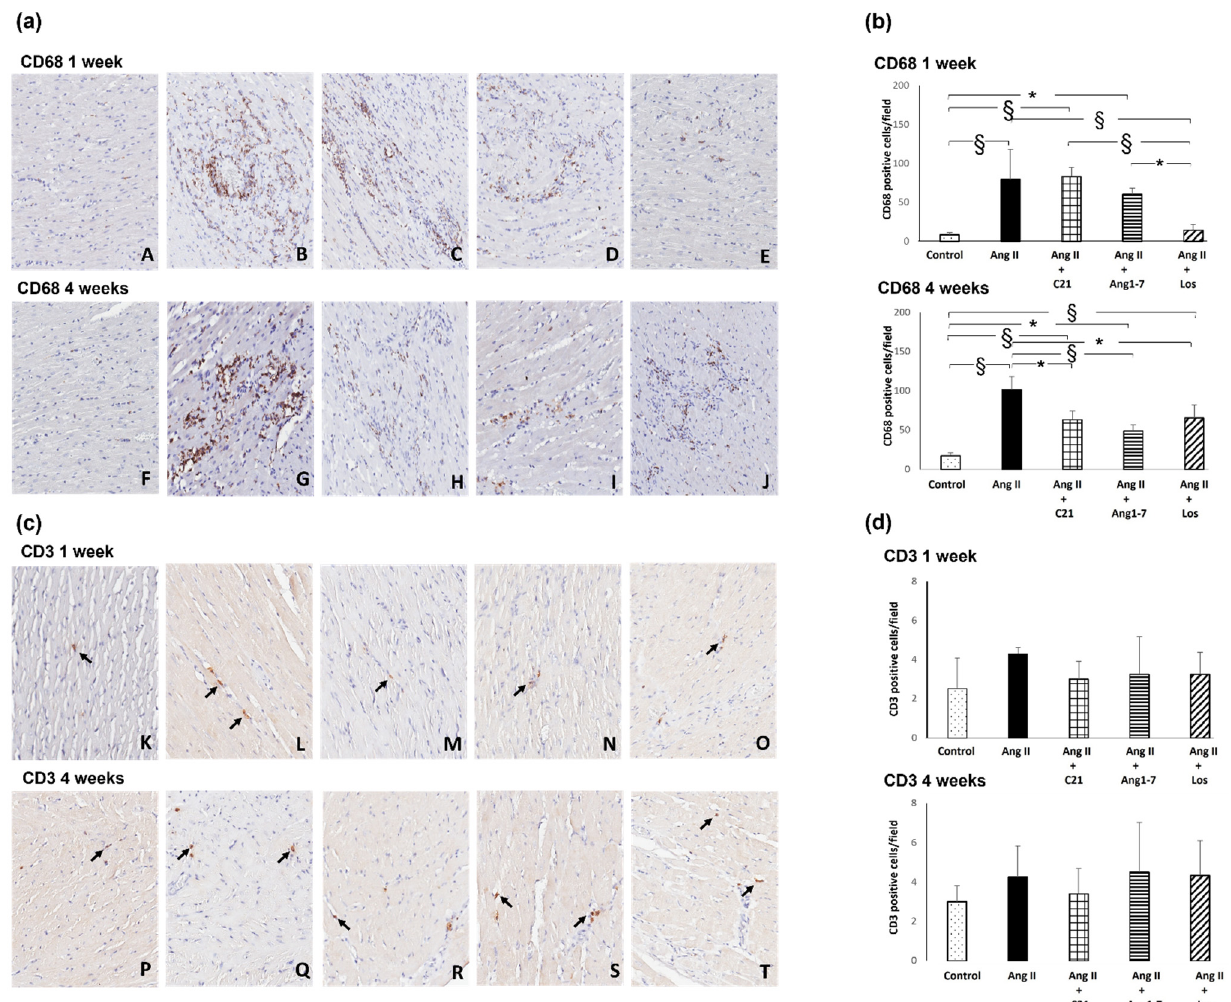
Figure 4. Myocardial inflammatory cell infiltration. Effects of C21 and Ang 1-7 administration on myocardial inflammatory cell infiltration in Ang II treated rats for 1 and 4 weeks. ( a ). Immunohistochemical identification of interstitial mono- cyte/macrophage infiltration (brown reaction) in control (A,F), Ang II (B,G), Ang II + C21 (C,H), Ang II + Ang 1-7 (D,I) and Ang II + Los (E,J) treated rats (×20 magnification), at 1 and 4 weeks of treatment. ( b ). Quantification of staining of myocar- dial monocyte/macrophage inflammatory cells in the different groups of rats. Data are means ± SEM. *: p < 0.05. §: p < 0.01. ( c ). Immunohistochemical identification of interstitial T-lymphocyte infiltration (brown reaction) in control (K, P ), Ang II (L,Q), Ang II + C21 (M,R), Ang II + Ang 1-7 (N,S) and Ang II + Los (O,T) treated rats (×20 magnification), at 1 and 4 weeks of treatment. ( d ). Quantification of staining of myocardial T-lymphocyte inflammatory cells in the different groups of rats. Data are means ± SEM.